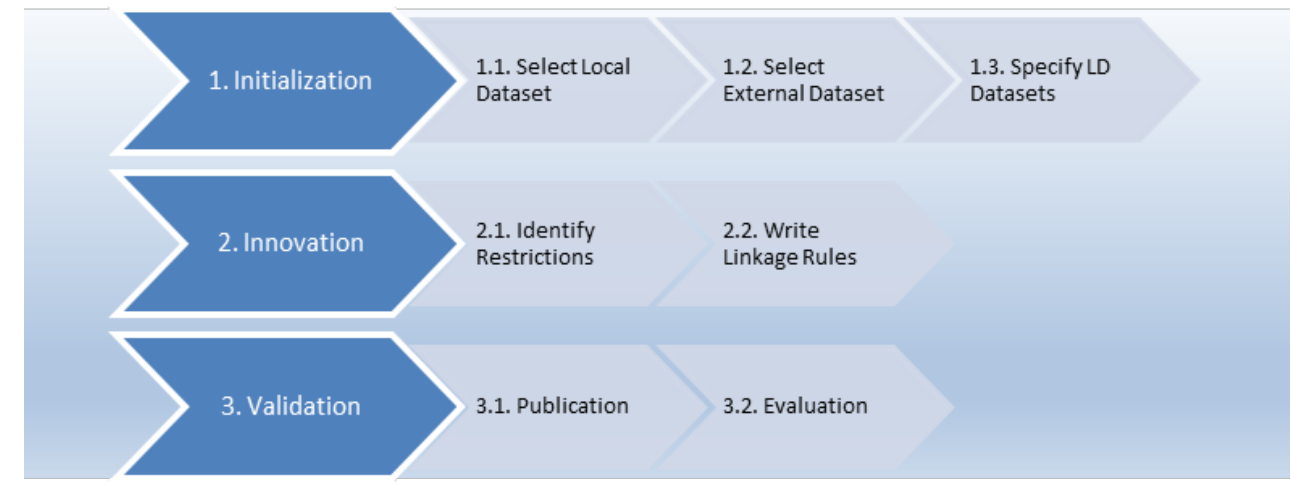
Figure 1. LD generation methodology.